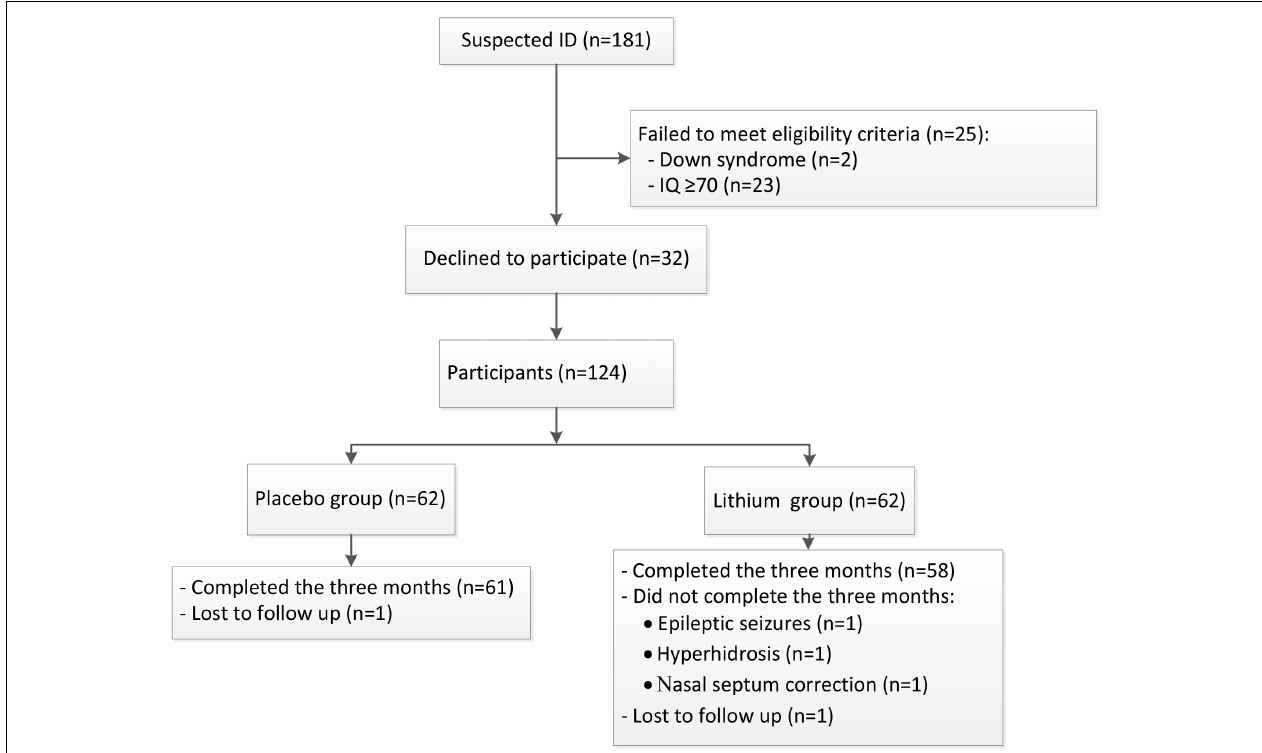
FIGURE 1 | The study flow. A schematic flowchart shows the number of participants who were screened for eligibility, randomly assigned to the lithium or placebo groups, and followed up to 3 months. Lost to follow-up means that contact with the family was lost during the follow-up period.